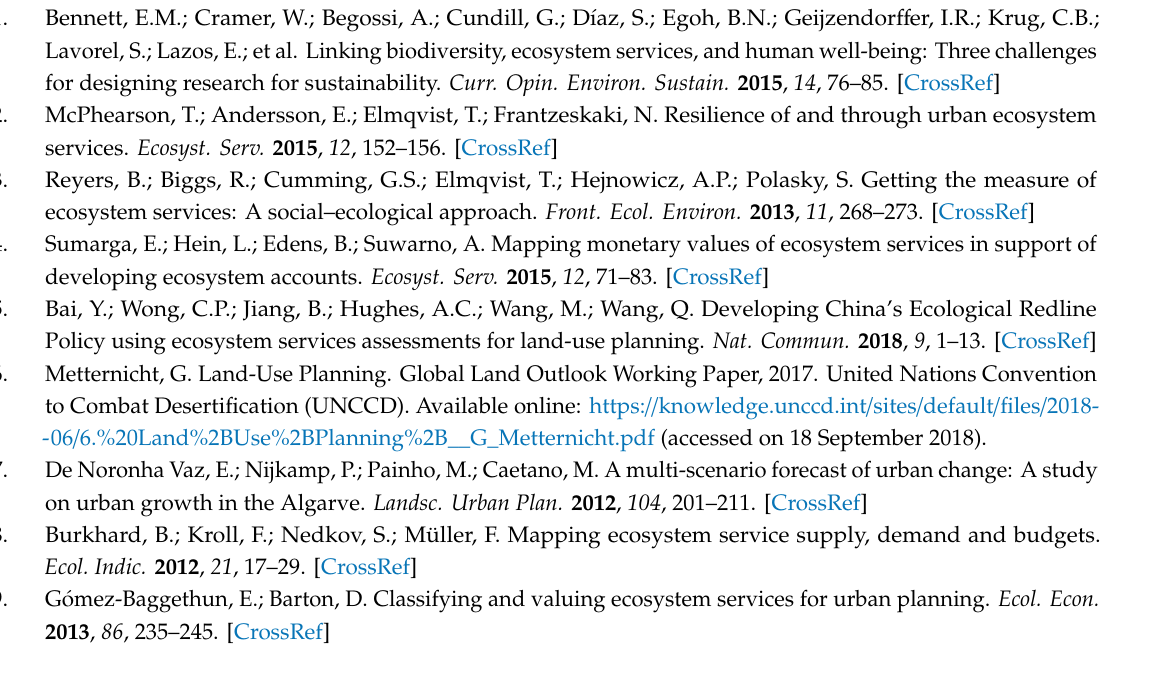
Table S5. Applied future land-use strategy. Table S6. Ecosystem service values provided by land-use strategies in Bolgatanga. Ecosystem service values based on the current land-use pattern are used as reference values (R), in blue color. The highest value of each ecosystem service is expressed as green color (the provision of construction materials is excluded as it is equally increased by all land-use strategies). The best land-use strategies that have the potential to provide more than three di ff erent ES with the highest values are expressed as yellow color. Table S7. Ecosystem service values provided by land-use strategies in Bongo. Ecosystem service values based on the current land-use pattern are used as reference values (R), in blue color. The highest value of each ecosystem service is expressed as green color (the provision of construction materials is excluded as it is equally increased by all land-use strategies). The best land-use strategies that have the potential to provide more than three di ff erent ES with the highest values are expressed as yellow